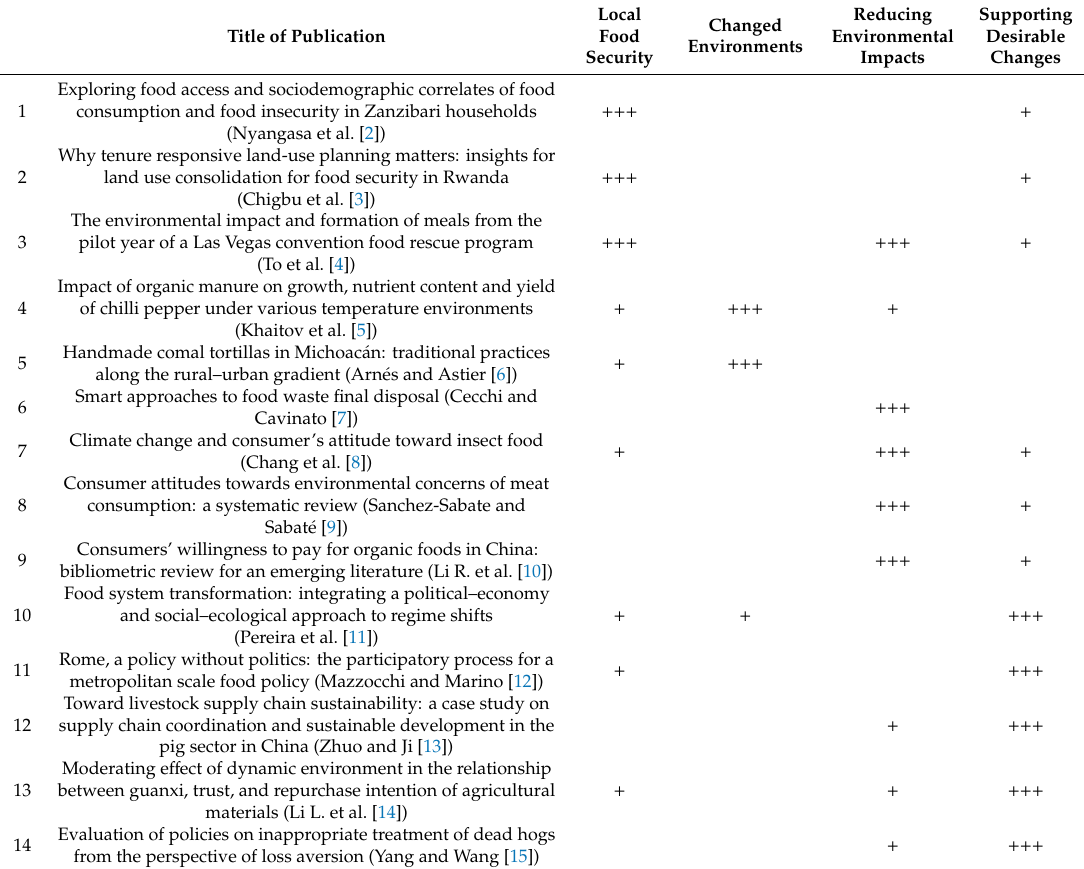
Table 1. Publications in the Special Issue ‘Towards More Sustainable Food Systems’, listed in the order as they are discussed in this editorial ( +++ : main focus area of publication; + : integrated topic).